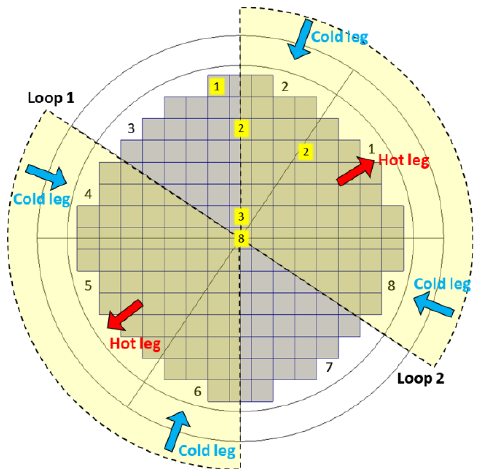
Figure 17. The quantitative distribution of the additional PIPEs at the core inlet/outlet planes of the AP1000 reactor. AP1000 reactor.